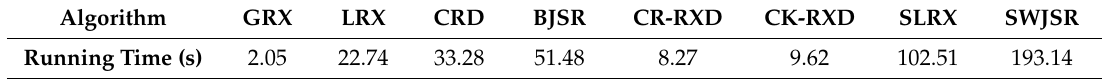
Table 4. Average running time of the compared algorithms using all